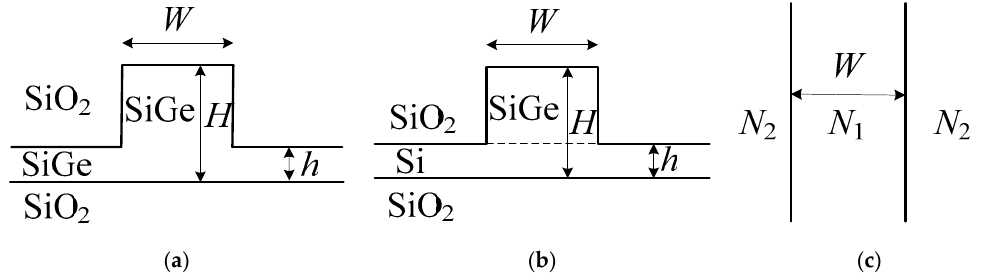
Figure 1. The structure of ( a ) Silicon Germanium-On-Insulator (SiGe-OI) optical waveguide, ( b ) Silicon Germanium-Silicon-On-Insulator (SiGe-SOI) optical waveguide and ( c ) equivalent